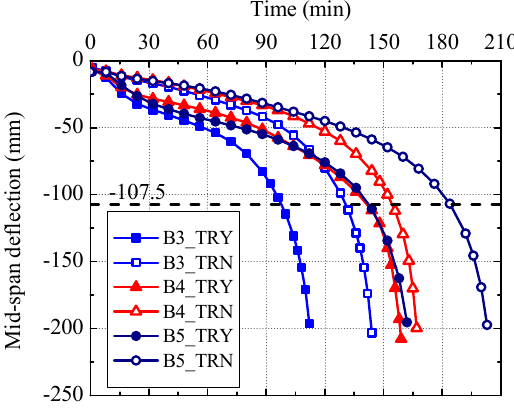
Figure 27. Effect of interface thermal resistance on mid-span deflection.